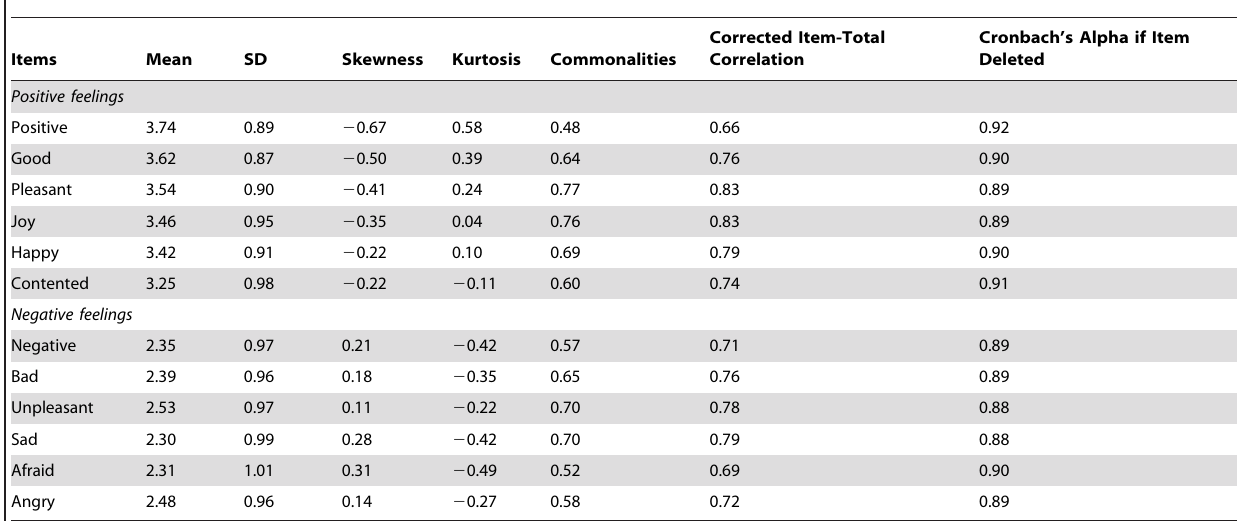
Table 2. Results of item analysis for the SPANE ( N =21,322